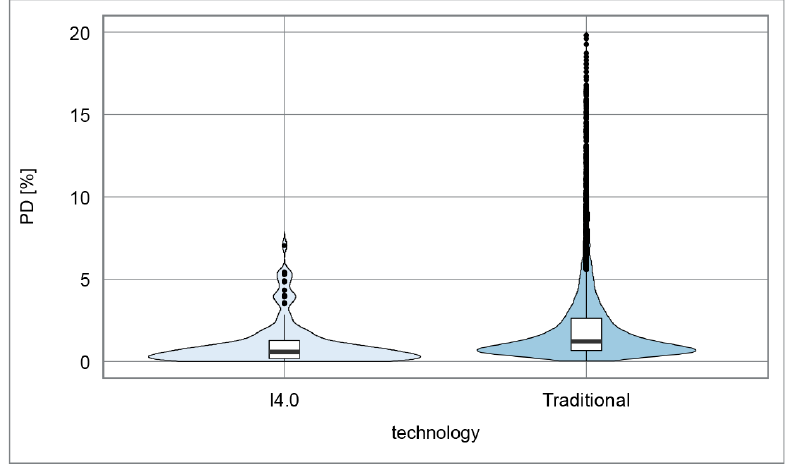
Figure 12. Distribution of probability of default (PD). Table 9. ANOVA of probability of default .